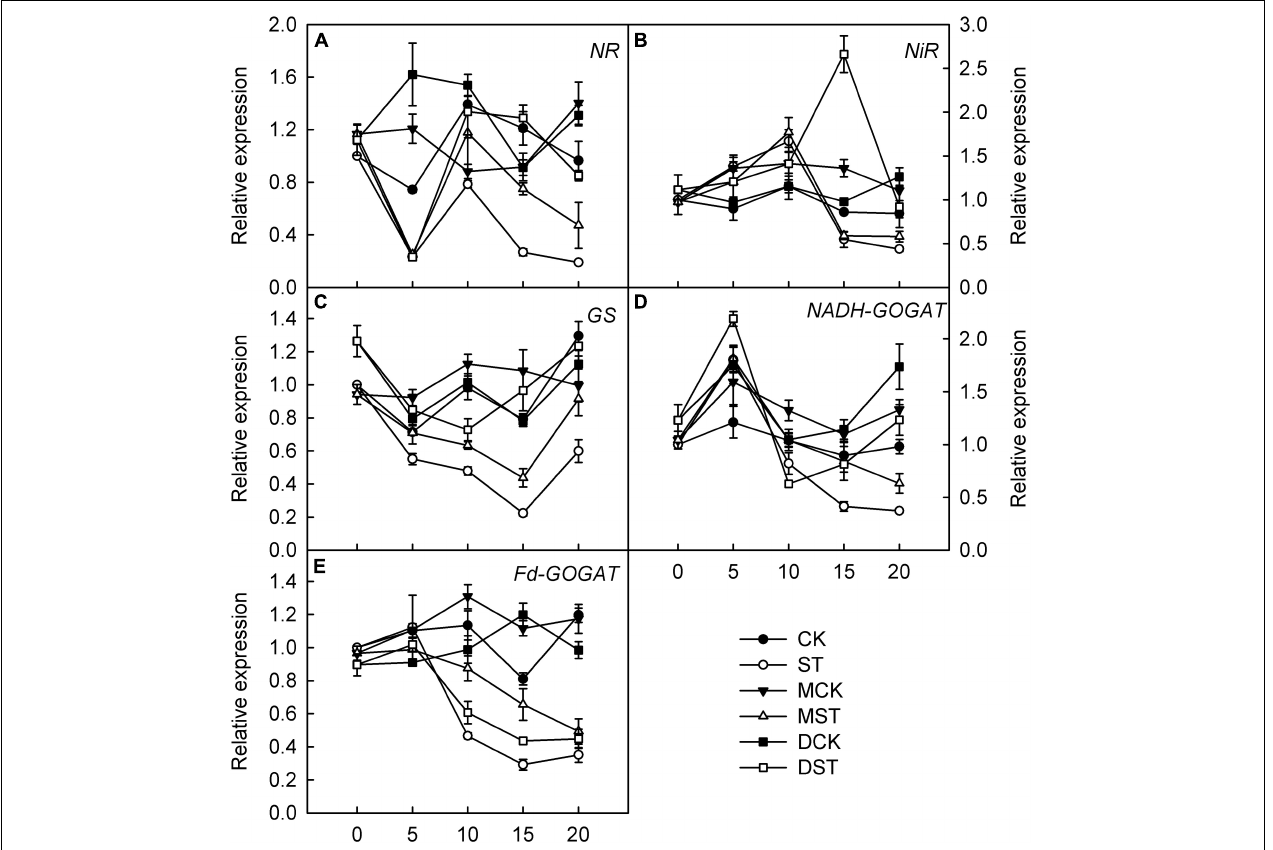
FIGURE 6 | Effects of melatonin and dopamine on expression of key genes involved in N-assimilation in leaves under different treatment conditions. (A) NR. (B) NiR. (C) GS. (D) NADH-GOGAT. (E) Fd-GOGAT. Total RNA was isolated from samples at specified time points (0–20 days), converted to cDNA, and subjected to qRT-PCR. Data are means ± SD ( n = 3). CK, 2 mM K 15 NO 3 solution; ST, 0.1 mM K 15 NO 3 solution; MCK, 2 mM K 15 NO 3 solution with 0.1 µ mol/L melatonin; MST, 0.1 mM K 15